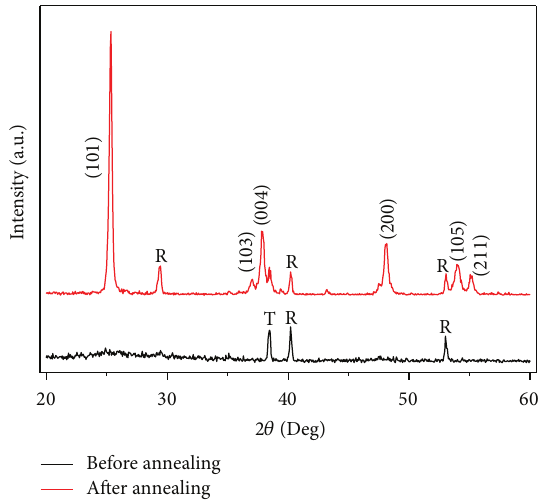
Figure 2: Comparison on the XRD patterns of TNT arrays before and after annealing.